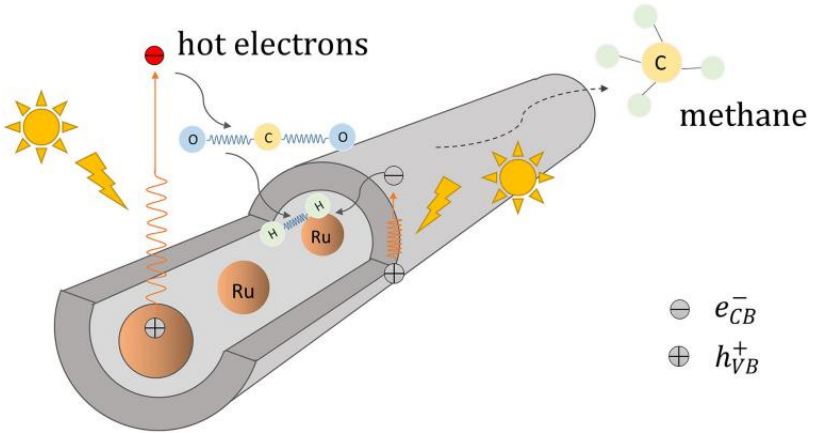
Figure 5. The reaction pathway for the Ru entrapped in the TiO 2 nanotubes catalyzes CO 2 methana- tion [37].